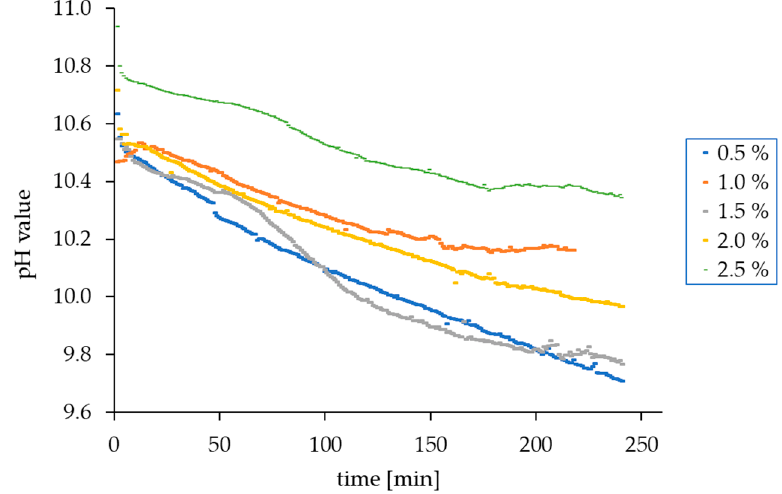
Figure 6. A decrease in the pH value of AMPD solutions with various concentrations over the model skin sebum within 240 min.